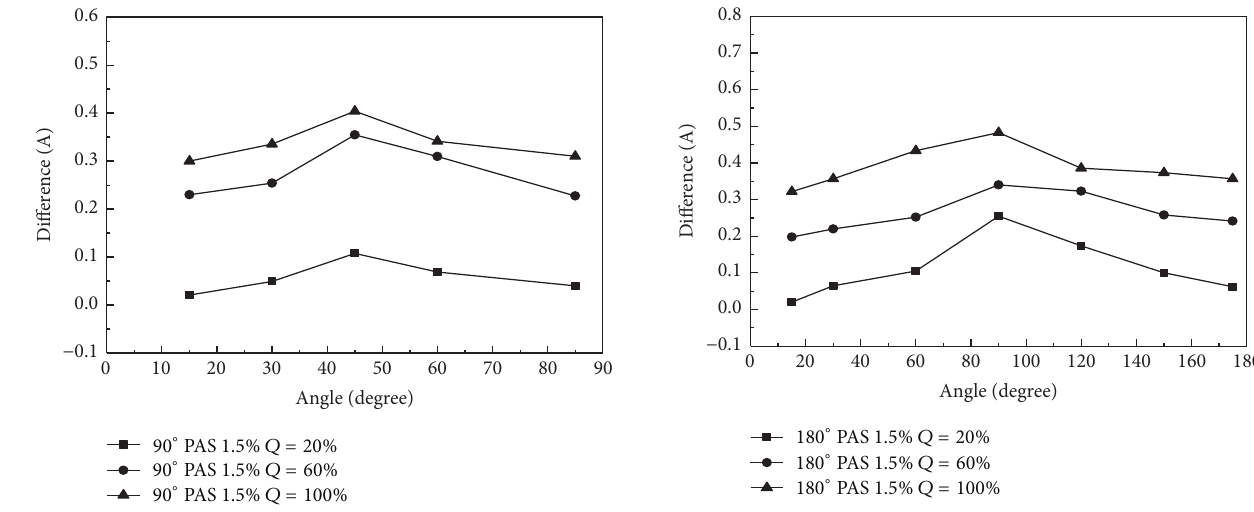
Figure 25: The PAS 1.5% angle of curved tube: difference diagram of various flows in 180 ∘ curved tube.